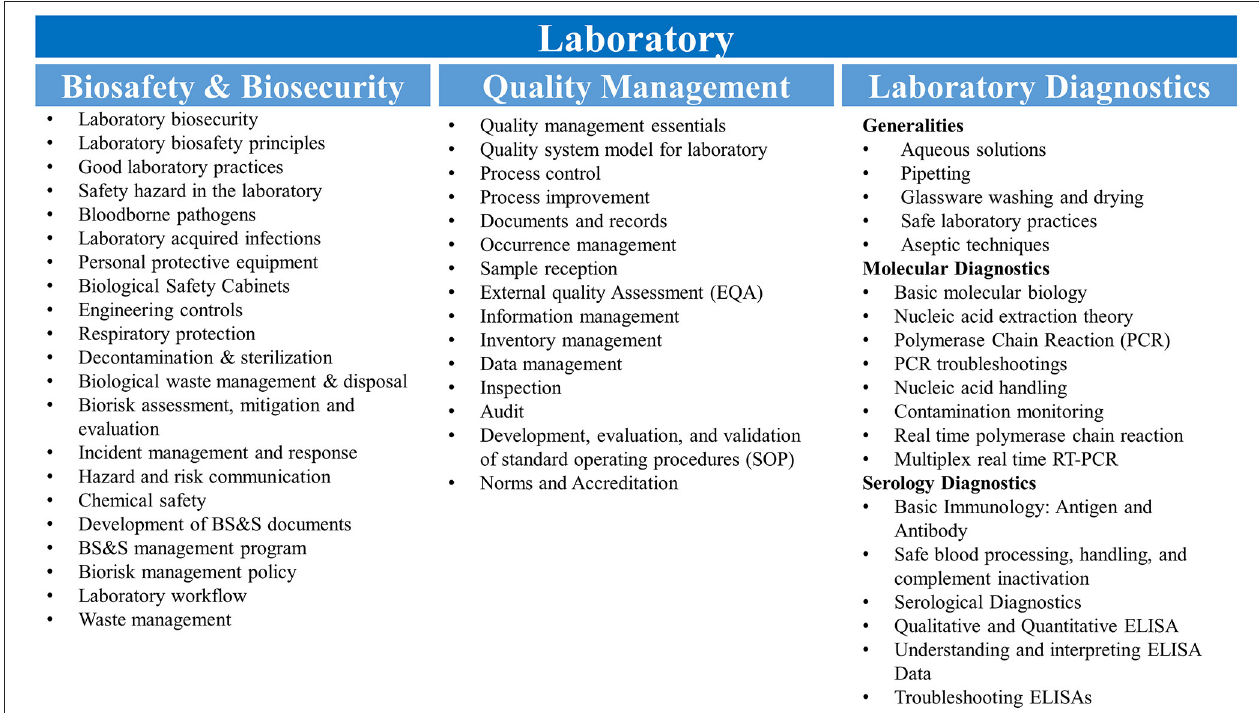
FIGURE 1 | Training curricula. Topics covered for the biosafety & biosecurity, quality management and molecular and serological diagnostics are shown. RT-PCR, reverse transcription polymerase chain reaction; ELISA, enzyme-linked immunosorbent assay.